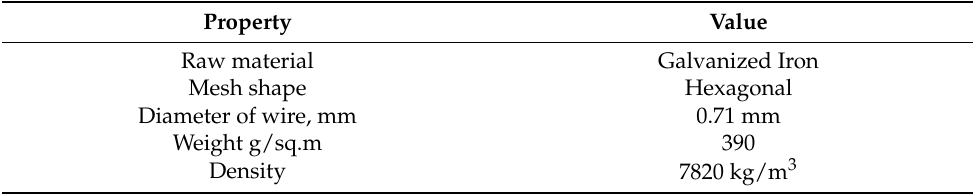
Table 3. Specifications of chicken mesh